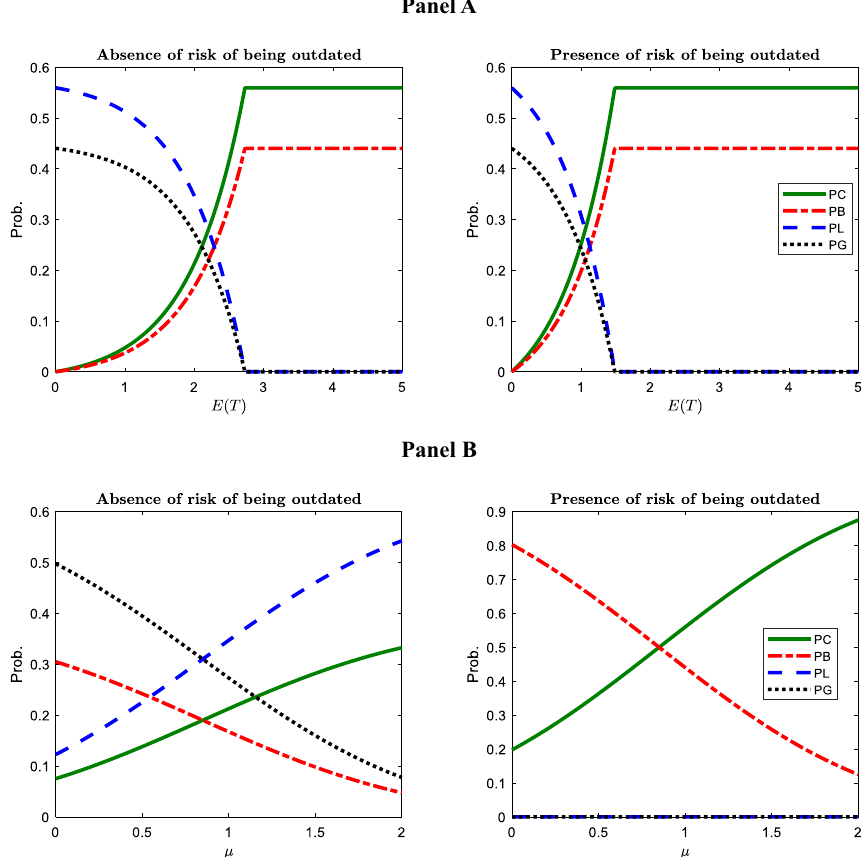
Fig. 4 Risk of being outdated: Probabilities of the four strategies under ambiguity. PC , PB , PL , and PG represent the probabilities of pursuing compulsive, buy‑and‑hold, leapfrog, and laggard strategies, respectively. To obtain conservative results, we choose a low level of ambiguity ( c = 0.4 ) as managers’ perceived ambiguity. Panels A and B show the innovation strategies for varying E ( T ) and for varying µ , respectively. Compared with no risk of being outdated (left graphs), the risk of being outdated increases PC and PB (right